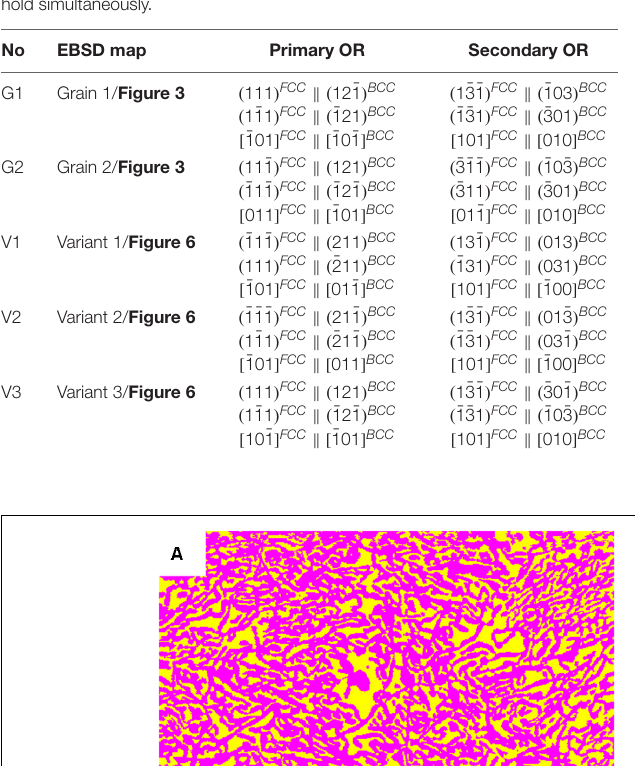
TABLE 3 | Crystal orientation relationship(s) identified in an as-cast sample AlCrFe 2 Ni 2 with ultrafine vermicular microstructure; the primary and secondary OR hold simultaneously.